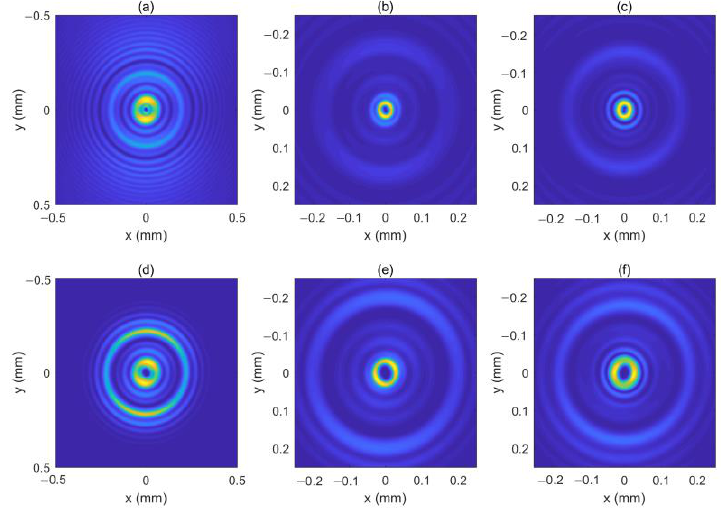
Figure 12. The intensity patterns of the LHCP component ( a – c ) and RHCP component ( d – f ) near the focal plane. ( a , c ), ( b , e ), and ( c , f ) show the intensity patterns for z = 140 mm, z = 145 mm, and z = 150 mm, respectively.